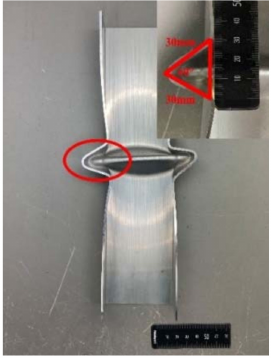
Figure 11. The A-A section of the first valley.